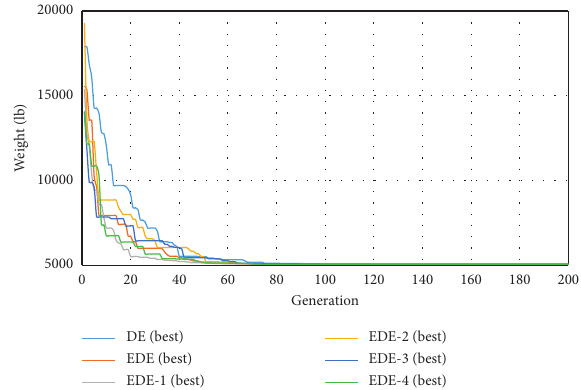
Figure 7: Convergence rates of DE, EDE, EDE-1, EDE-2, EDE-3, and EDE-4 for the 10-bar